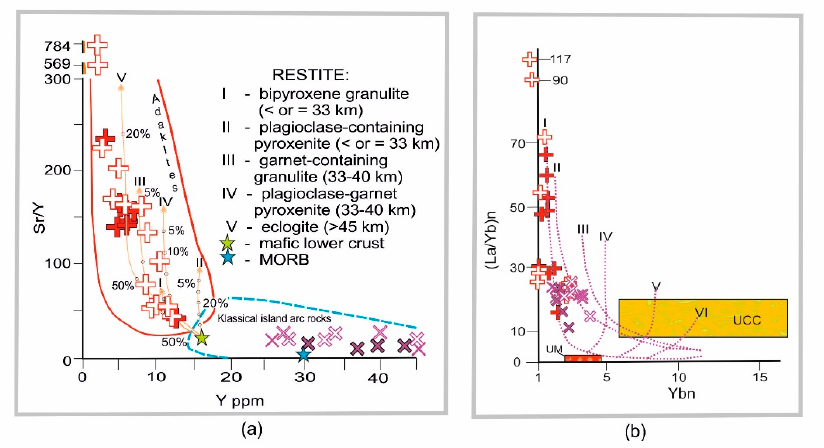
Figure 6. The position of the granitoids on the diagrams: (a) Sr/Y-Y [43–46]. Partial melting curves were calculated for the periodic melting of mafic rocks of the lower crust North China Craton from [47]. (b) the relations (La/Yb)n–(Yb)n according to [48] with the outlined trends of source melting according to [49]: I-quartz eclogites; II-garnet amphibolites; II-amphibolites; IV-garnet-containing mantle, with a garnet content of 10%; V-a garnet-bearing mantle, with a garnet content of 5%; VI-garnet-containing mantle, with a garnet content of 3%. UM-upper mantle; UCC-upper continental crust. See the legend in Figure 3.